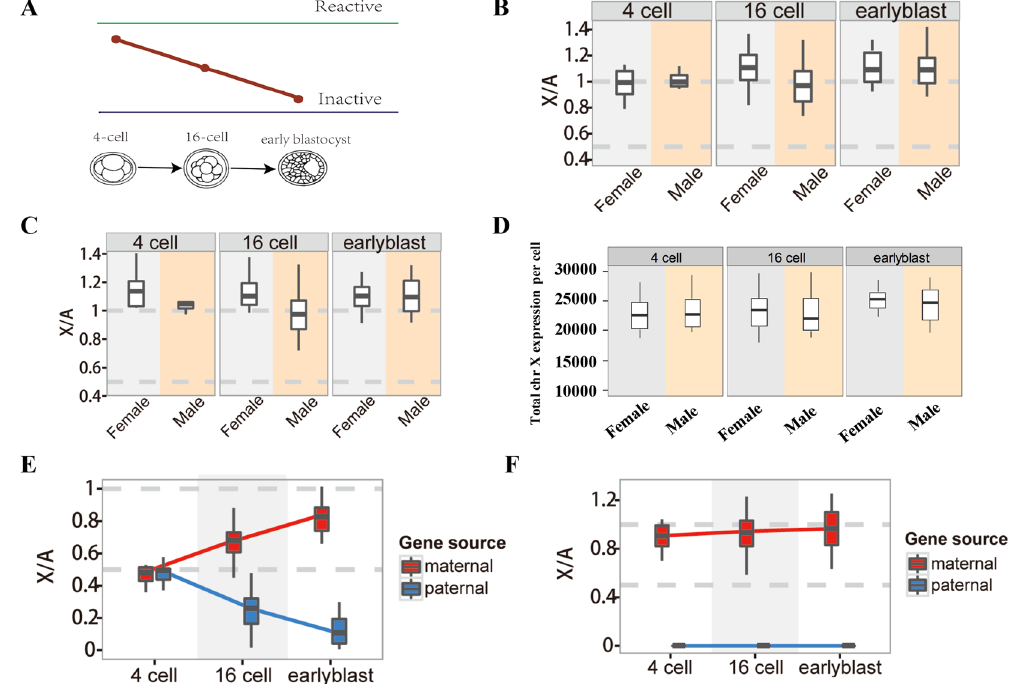
Figure 4. Comparisons of RNA-Seq gene expression levels between the X chromosome and autosomes in mouse early embryogenesis. ( A ) Schematic illustration of the process of inactivation in mouse early embryogenesis: The initiation of iXCI begins at early preimplantation in embryos and Xp-Xist is expressed around the four-cell stage. Next, the active paternal X chromosome becomes gradually inactive from the four- cell stage to early blastocyte stage to form a process from X reactivation to X inactivation. ( B ) X: A ratios of median expressions according to all reads for each sex and embryonic day. There were no differences between each types of embryonic cells and between males and females. (P > 0.05, by Student’s t-test). ( C ) X: AA ratios of median expressions according to SNP-containing reads for each sex and embryonic day. There were no differences between each types of embryonic cells and between males and females. (P > 0.05, by Student’s t-test). ( D ) Boxplots showing the distribution of cellular X chromosome FPKM sums for each sex and embryonic day. There were no differences between each types of embryonic cells and between males and females. (P > 0.05, by Student’s t-test). ( E ) Comparisons of X: AA ratios of median expressions between paternal X chromosome and maternal X chromosome from female 4-cell stage (N = 11), 16-cell stage (N = 21) and early blastocyst stage (N = 15) in female embryo. ( F ) Comparisons of X: AA ratios of median expressions between paternal X chromosome and maternal X chromosome from male 4-cell stage (N = 3), 16-cell stage (N = 27) and early blastocyst stage (N = 28) in male embryo. N represents the number of single cell RNA-seq data with this stage in the parentheses after early embryogenesis. The percentiles in all boxplots are 0.05, 0.25, 0.5, 0.75 and